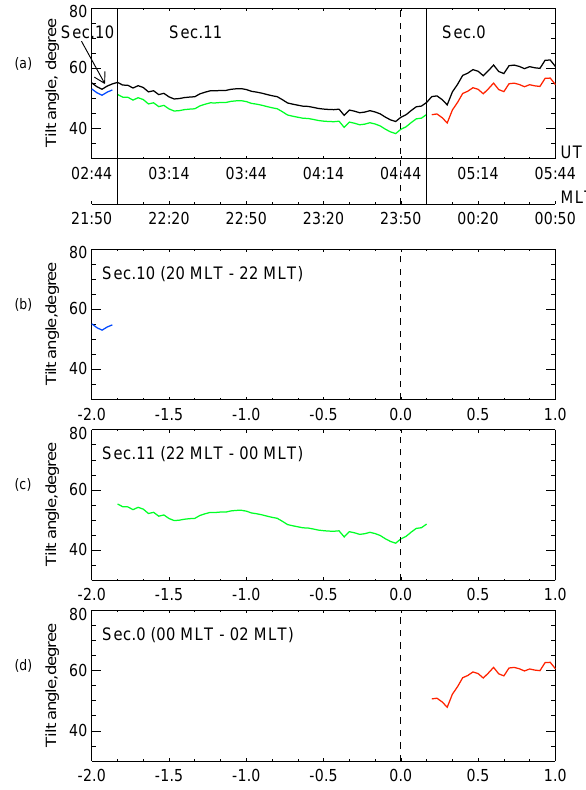
Fig. 1. An example shows the superposed epoch methodology that is applied to each event used in the averaging process. The top panel shows a 3-h variation of the tilt angle in black. The magnetic local time is also shown beneath the universal time. The vertical dashed line marks the onset time and two vertical solid lines divide the interval into three parts according to the local time. The different parts are marked in three different